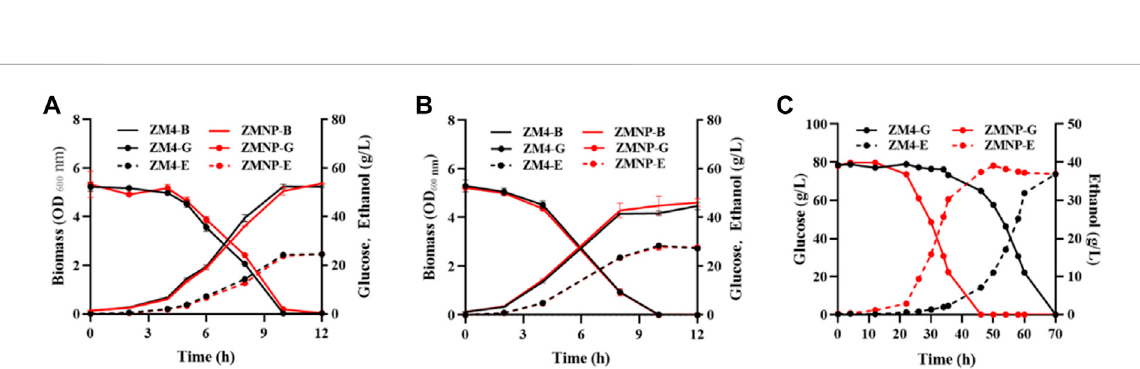
FIGURE 2 The effect of different temperatures and xylose mother liquor of Z. mobilis ZM4 and ZMNP. Growth, glucose consumption and ethanol production of ZMNP and ZM4 under 30 ° C (A) and 40 ° C (B) . Fermentation performance between ZMNP and ZM4 using xylose mother liquor (C)